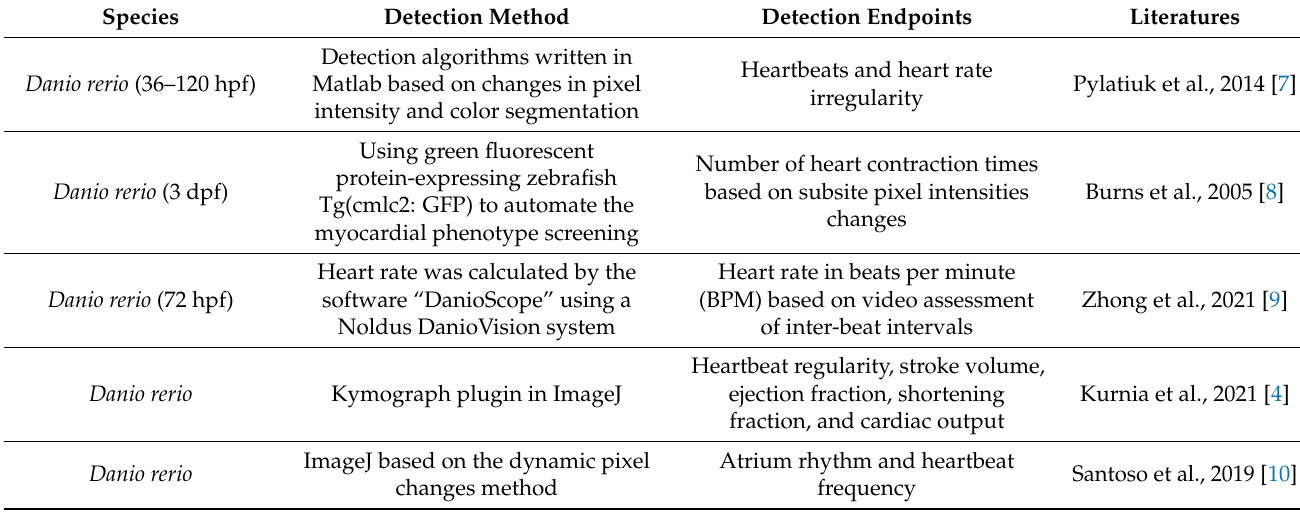
Table 1. Summary of previous detection methods and endpoints for cardiac physiology